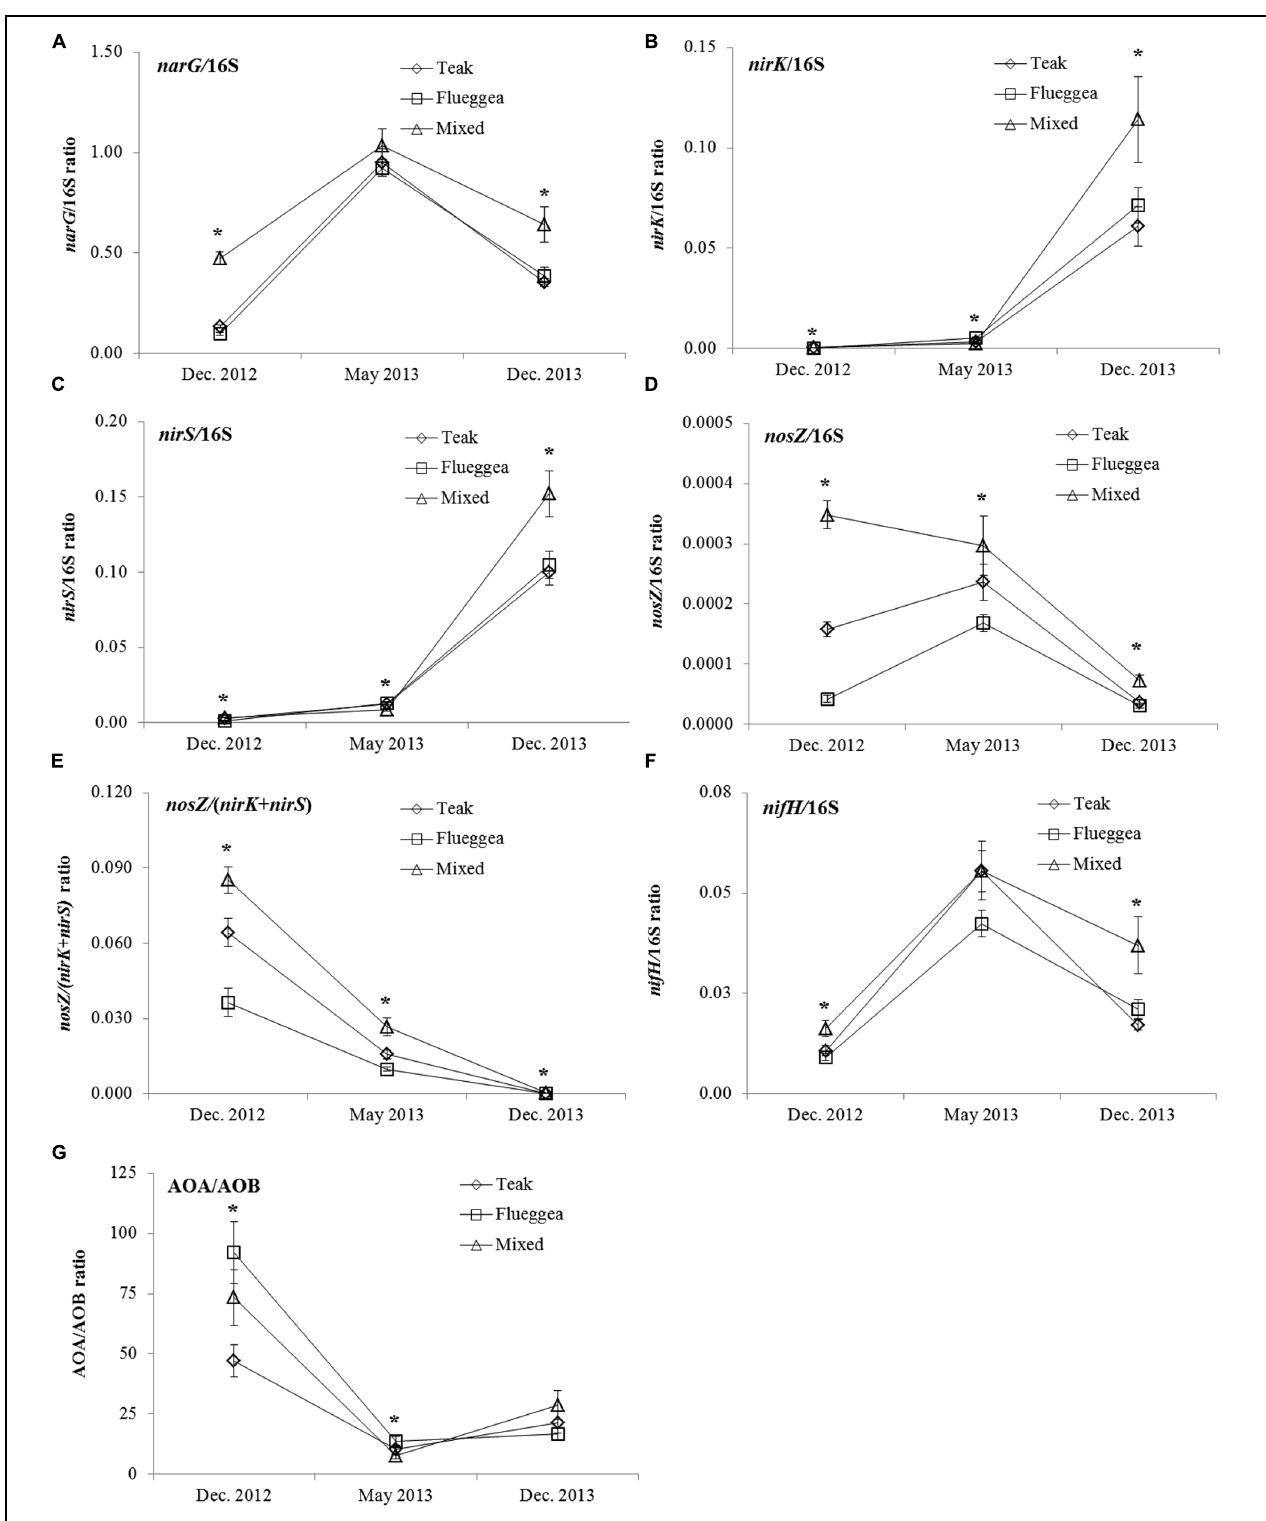
FIGURE 4 | Relative abundance of the narG (A), nirK (B), nirS (C), nosZ (D) genes, nosZ/(nirK + nirS) ratio (E), relative abundance of the nifH gene (F), and AOA/AOB ratio (G) in soil under plantations of teak (diamonds), flueggea (squares), and mixed species (triangles) at three sampling dates. Asterisks indicate significant differences between plantation types (Tukey HSD test, P < 0.05).